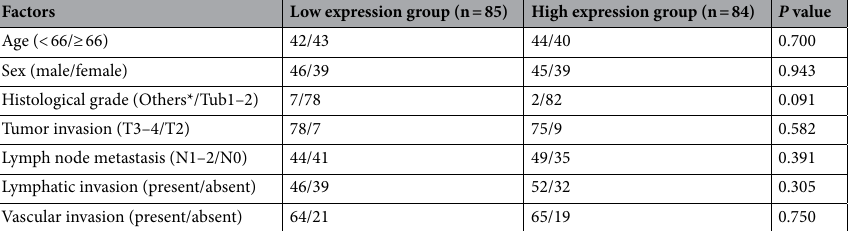
Table 1. Patient characteristics according to HNF1A mRNA expression. Tub1–2: well–moderately differentiated adenocarcinoma. *Others: poorly differentiated, mucinous adenocarcinoma, or squamous cell carcinoma.